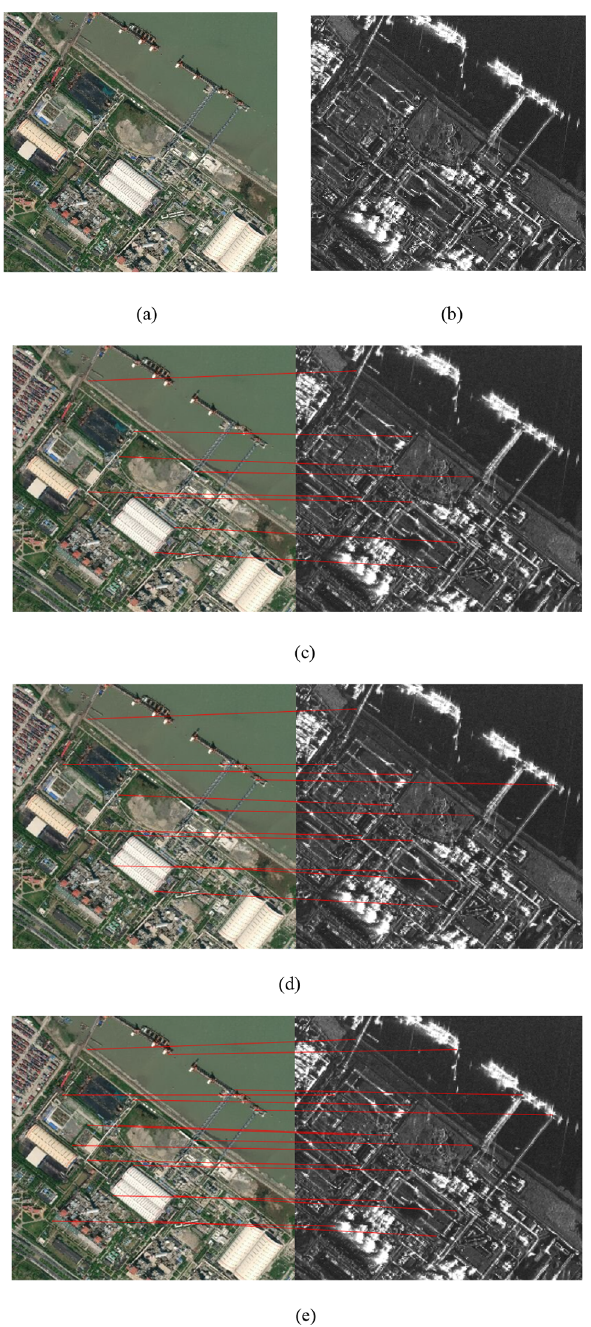
Figure 3. ( a ) Optical image; ( b ) SAR image; Matches found in pair 3 using ( c ) PSO-SIFT, ( d ) OS-SIFT, and ( e ) the proposed method. The reference image is shown on the left and the sensed image on the